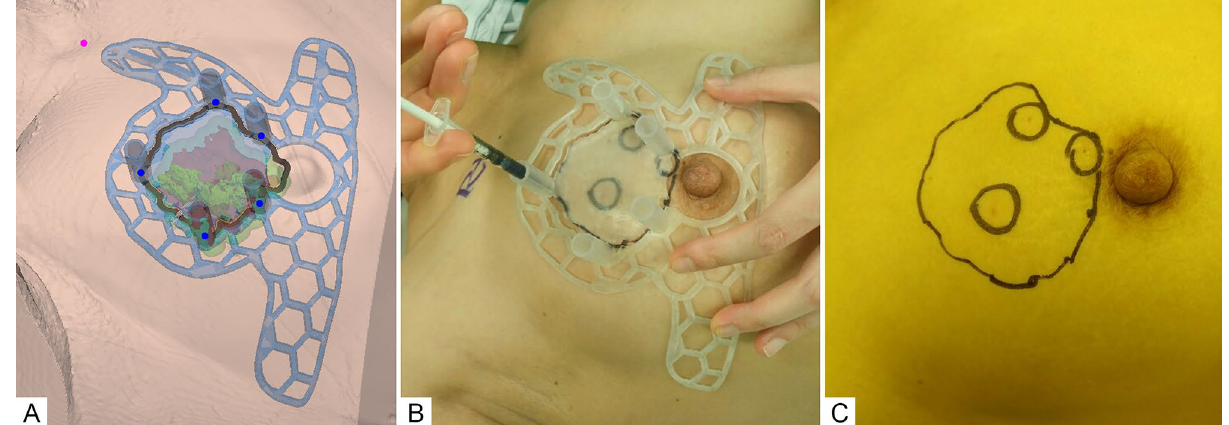
Figure 2. Tumor-targeting with patient-specific 3D printed-breast surgical guide (3DP-BSG) after neoadjuvant systemic therapy (NST). ( A ) MRI-based patient-specific 3DP-BSG modeling. ( B ) Marking of the tumor area on the skin surface using 3DP-BSG, and target the tumor inside the breast by injecting blue dye. ( C ) Tumors observed in USG (three inner circles) after NST and the original tumor area (external boundary) using